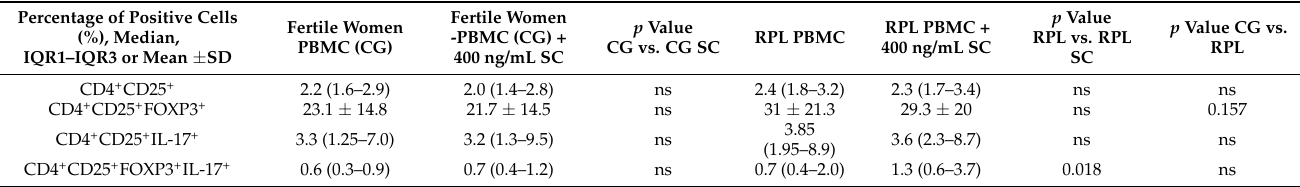
Table 2. The percentage of CD4 + CD25 + FOXP3 + − Treg, CD4 + CD25 + IL-17 + -activated Th17 and CD4 + CD25 + FOXP3 + IL- 17 + (Th17/Treg) positive cells determined among CD4 + CD25 + of the cultured PBMC of fertile women and RPL patients with and without SC for 48 h, results presented as the mean and SD in case of the normal distribution of data, and median and IQR1-IQR3 in case of the non-normal distribution of data, (CG—control group, n = 20; RPL—study group, n = 20; SC— sildenafil citrate).